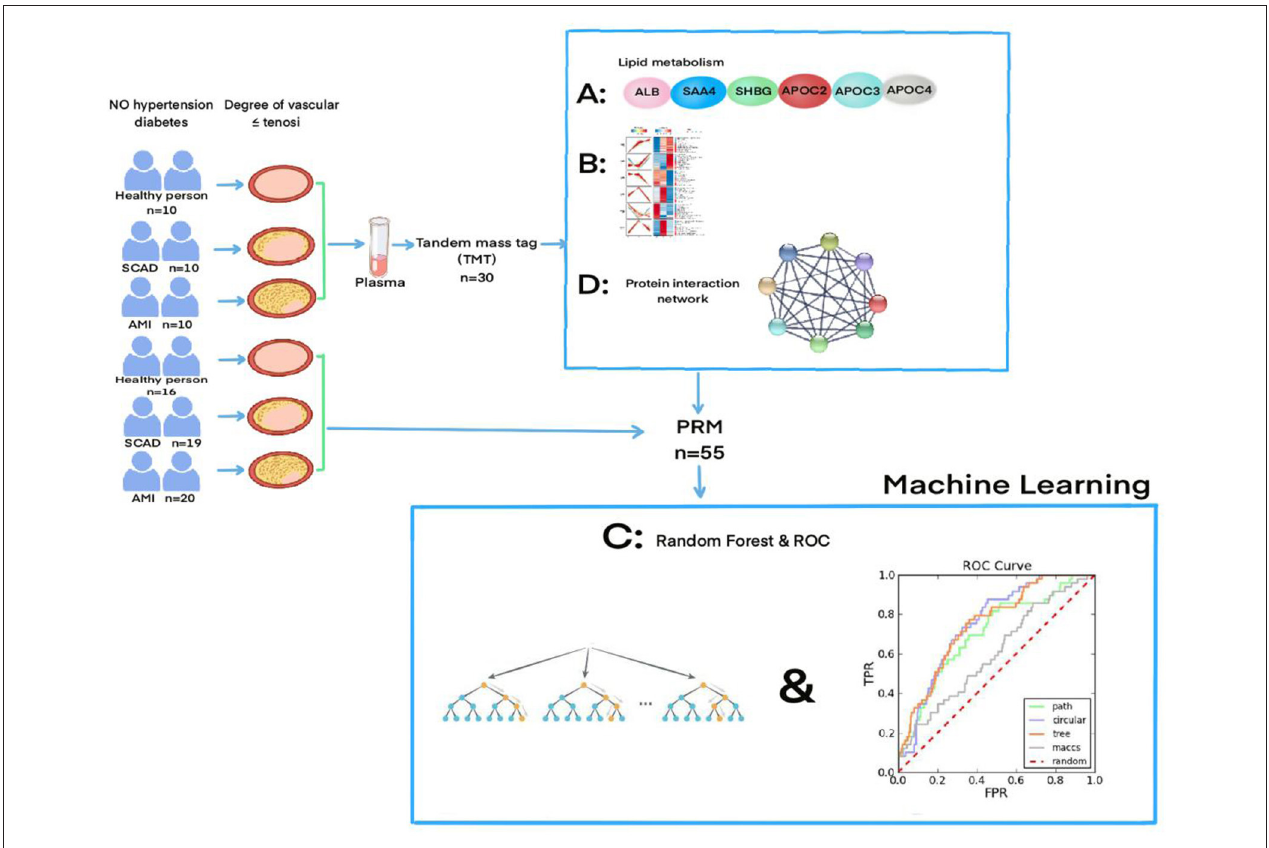
FIGURE 5 | The flowchart of the experiment and the specific experimental process can be found in the “Meterials and Methods part”, and “the result